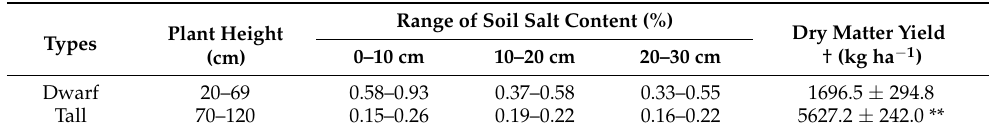
Table 2. Comparison of soil salt content and dry matter yield between dwarf and tall types of tall wheatgrass grown under saline